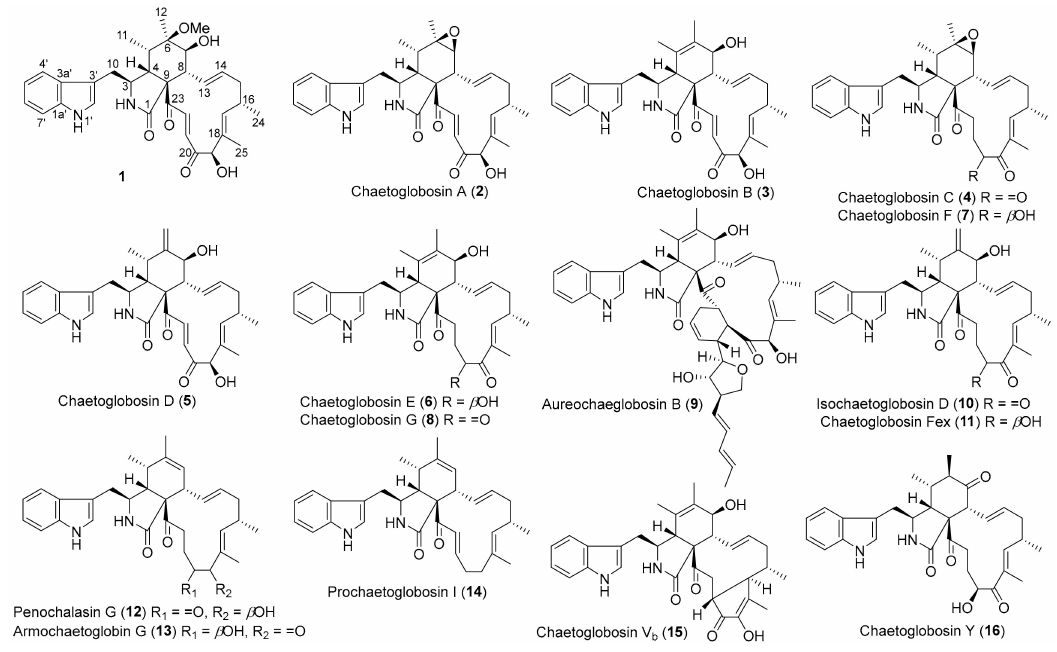
Figure 1. Chemical structures of compounds 1 - 16